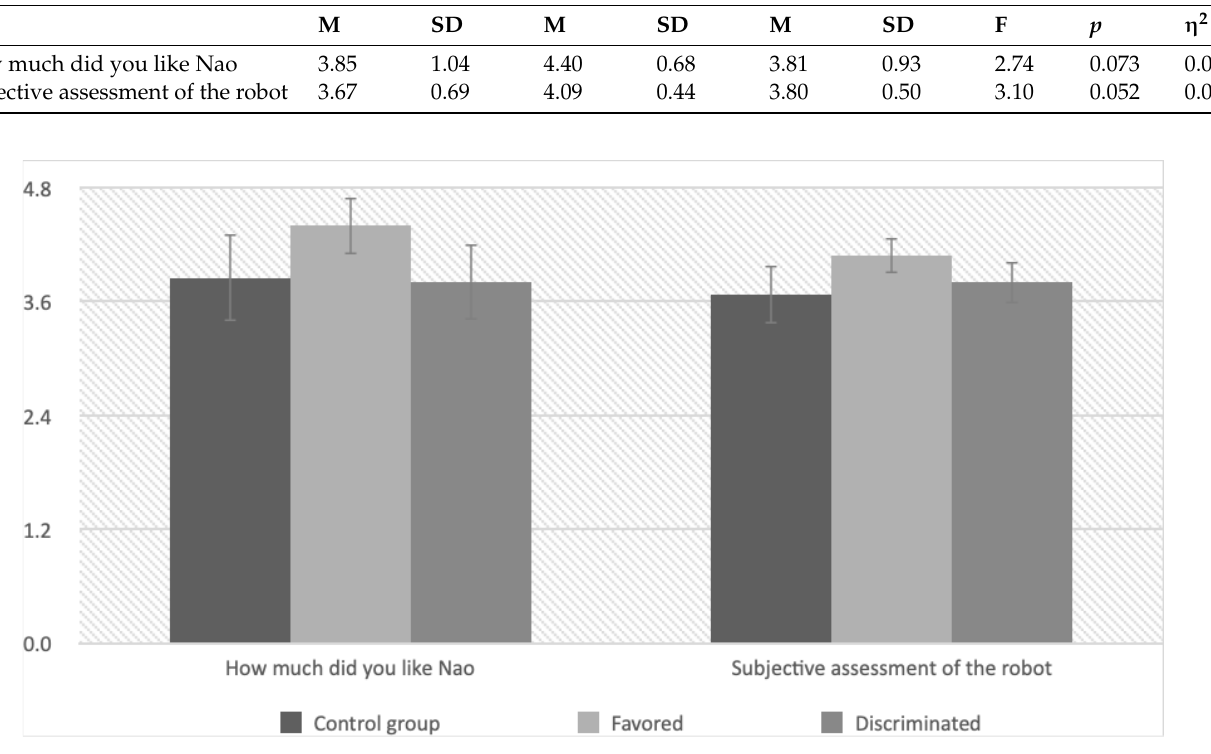
Table 4. Comparison of different groups for the feeling of belonging to the team and the feeling of being excluded from the team. Control Group ( n =